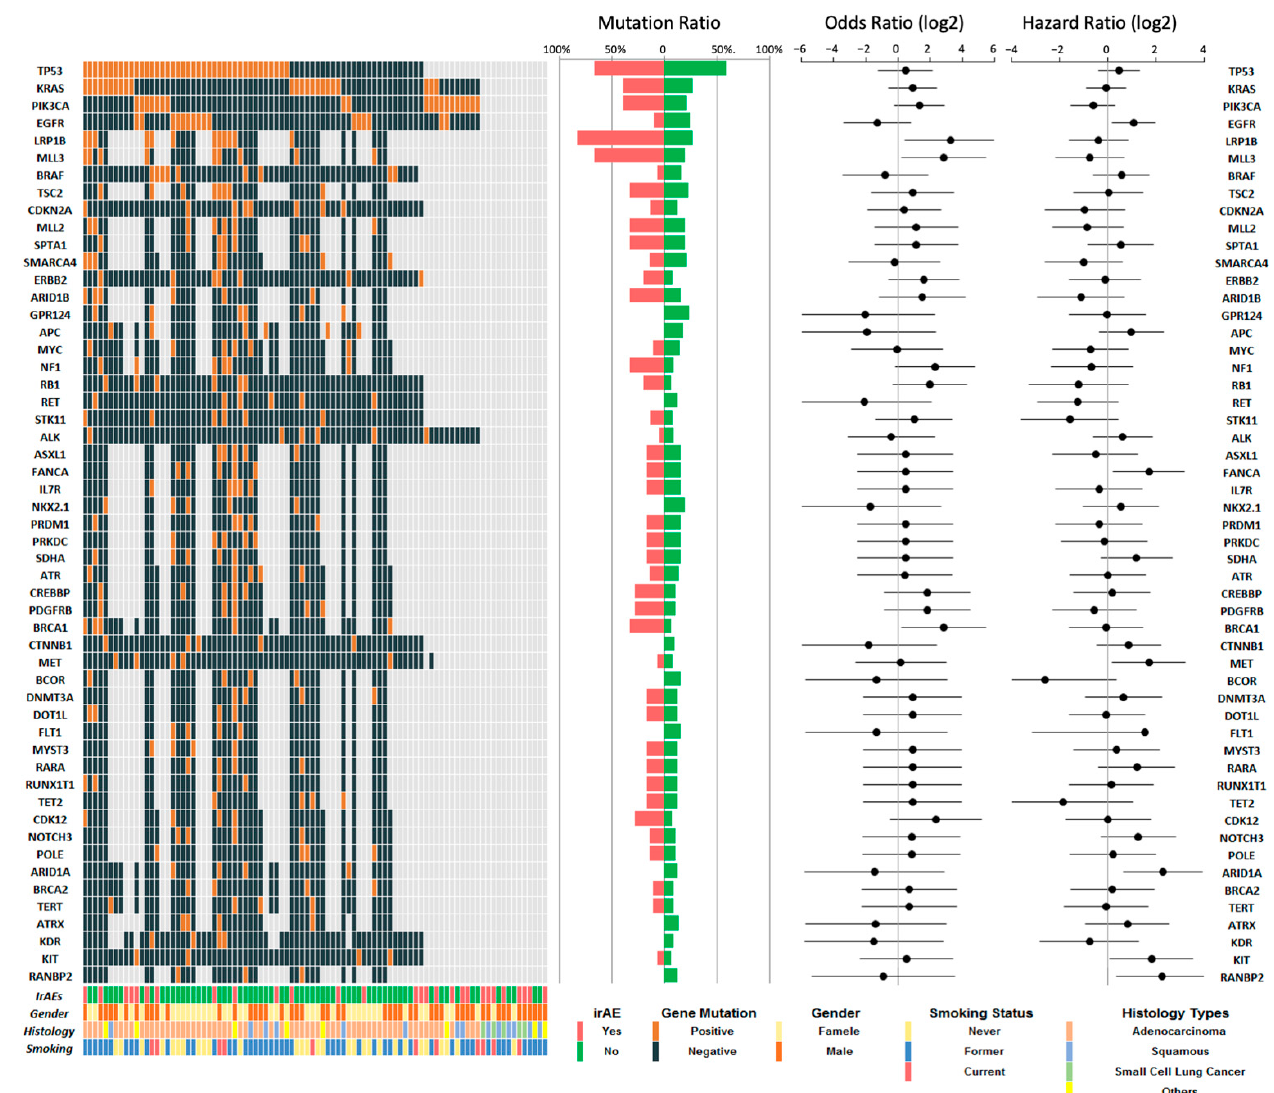
Figure 1. The top detected genomic alterations with OS and irAEs. Oncoplot demonstrating the patient demographic information and top detected genomic alterations in 90 lung cancer patients who were hospitalized during ICI treatment. Mutation rates are shown by patients with irAEs vs. no irAEs. The odds ratios were calculated using univariate logistic regression and hazard ratios with the univariate Cox model. Data visualization and statistical analysis were performed with R.